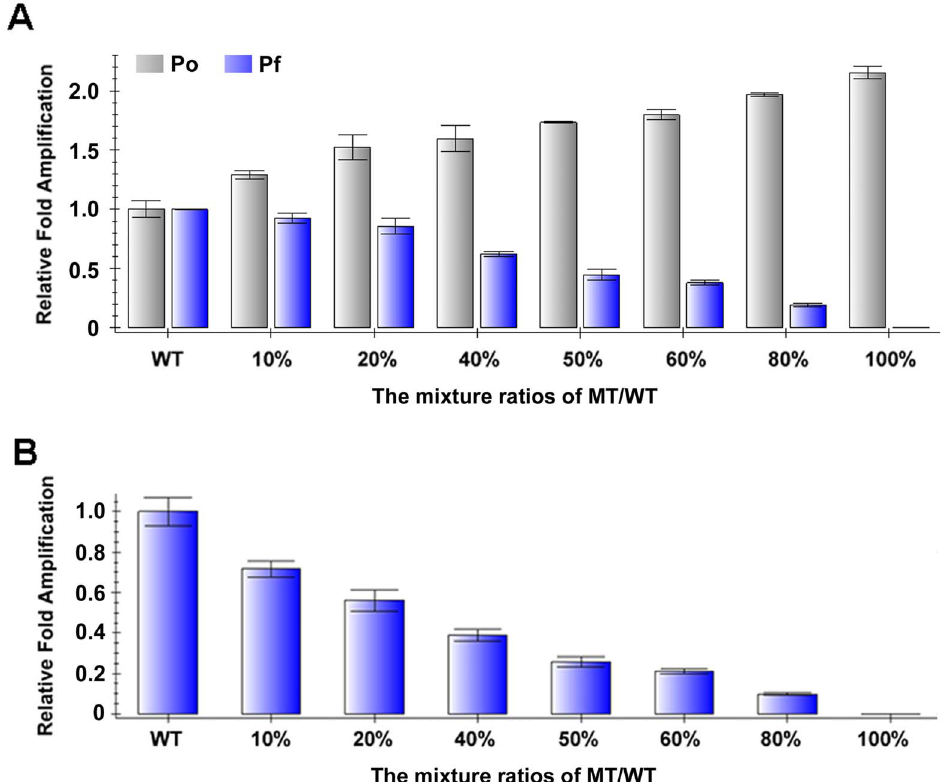
Figure 2. Determination of known mutations with qPCR. (A) Relative levels of Po or Pf PCR products. The amounts of Po or Pf PCR products of mixed templates were compared to the amount of corresponding PCR products of pure wild-type template. (B) Relative ratios between Po PCR products and Pf PCR products. The ratios between Po PCR products and Pf PCR products of mixed templates were compared to the ratio of wild-type template. WT, wild-type. MT, mutant.